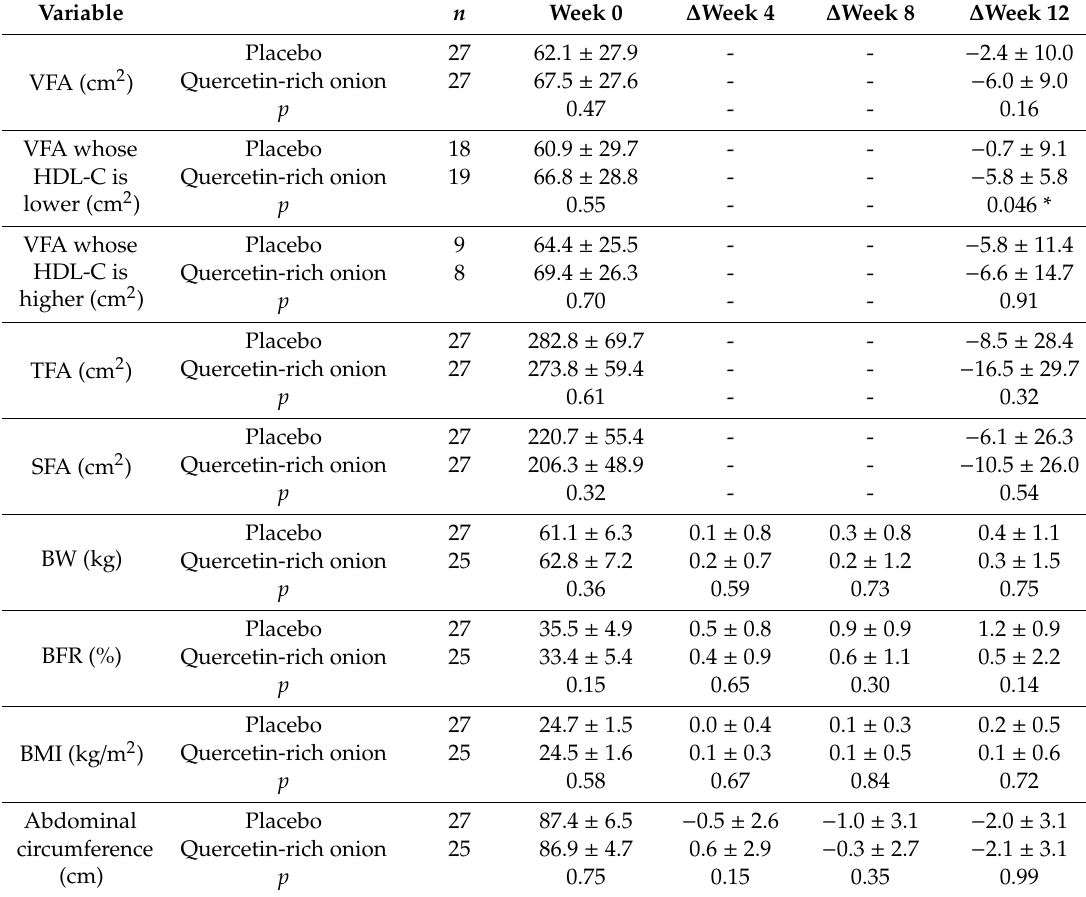
Table 5. Abdominal fat area and body composition of the placebo and quercetin-rich onion